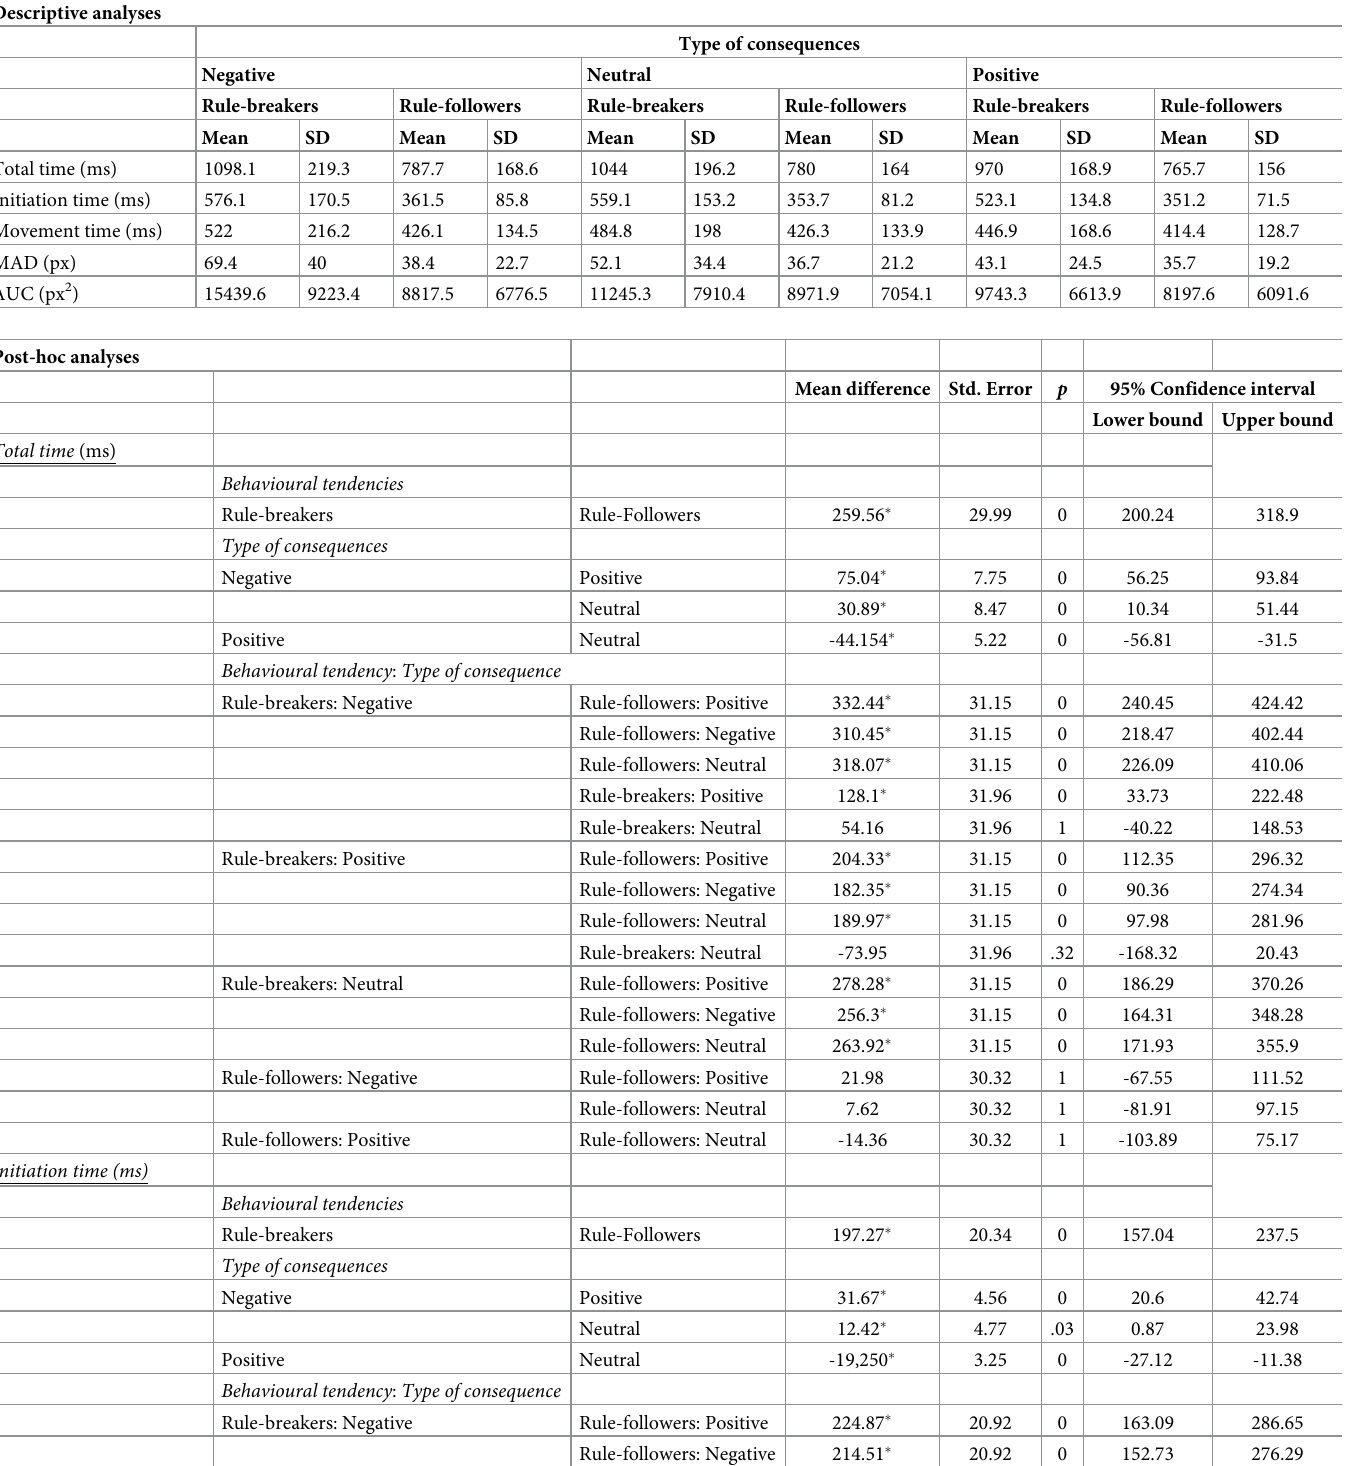
Table 1. Descriptive values and post-hoc results of reaction times and mouse trajectory parameters across behavioural tendency and type of consequences when fol- lowing the rule (i.e., neutral, positive, negative). Descriptive